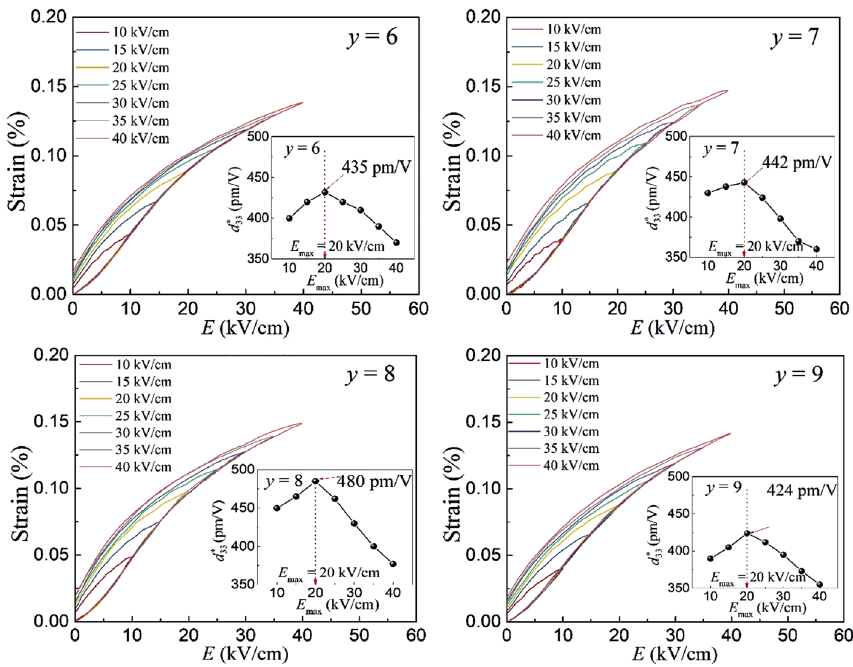
d for the poled KNNT–0.055BZ + 0.03Zr + y Mn ceramics. Fig. 6 Unipolar S – E curves and * 33 at y = 8 show a maximal * d value (480 33